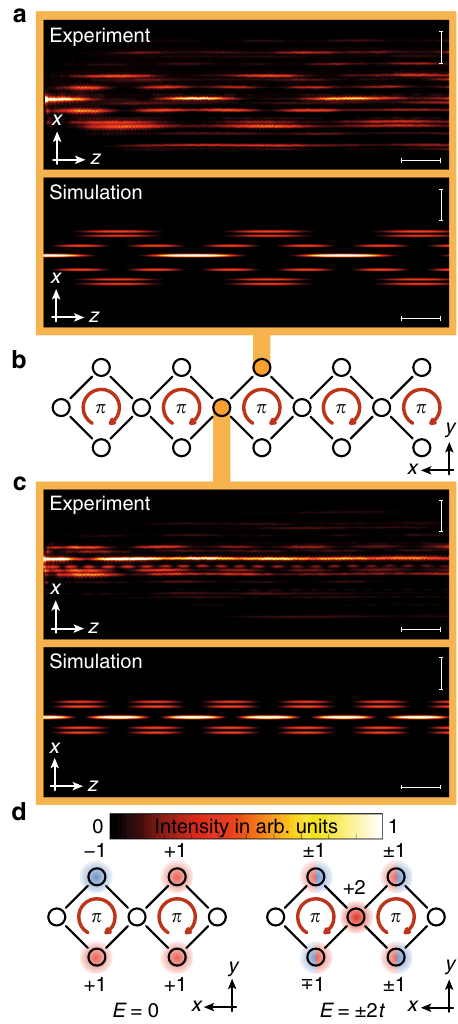
Fig. 4 Bulk dynamics. a Light dynamics when exciting the top waveguide in a bulk plaquette. The total envelope remains localized and shows breathing only within the plaquette. Differences between simulations and experiment arise mainly due to small amounts of light leaking into neighboring waveguides during the excitation of the waveguide. This generates a slightly different initial state launched into the system resulting in small deviations of the propagation dynamics. The horizontal scale bar corresponds to 1 cm, while the vertical scale bar corresponds to 50 μ m. b The two waveguides that are probed in the experiments demonstrating the fl atness of the bulk spectrum. c Light dynamics in the structure when a waveguide between two plaquettes is excited. The total envelope shows a local breathing while being localized within the plaquette. The horizontal scale bar corresponds to 1 cm, while the vertical scale bar corresponds to 50 μ m. d The amplitude distribution of the three bulk eigenstates of the